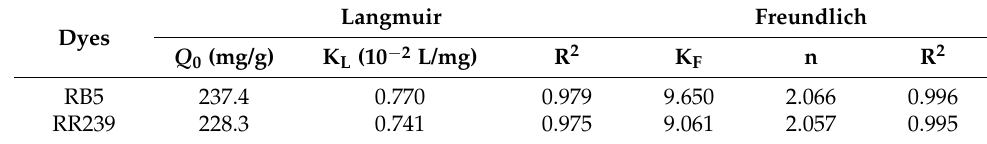
Figure 8. Langmuir ( a ) and Freundlich ( b ) adsorption isotherm plots. Table 3. The isotherm adsorption parameters for dyes on CM-ATP.